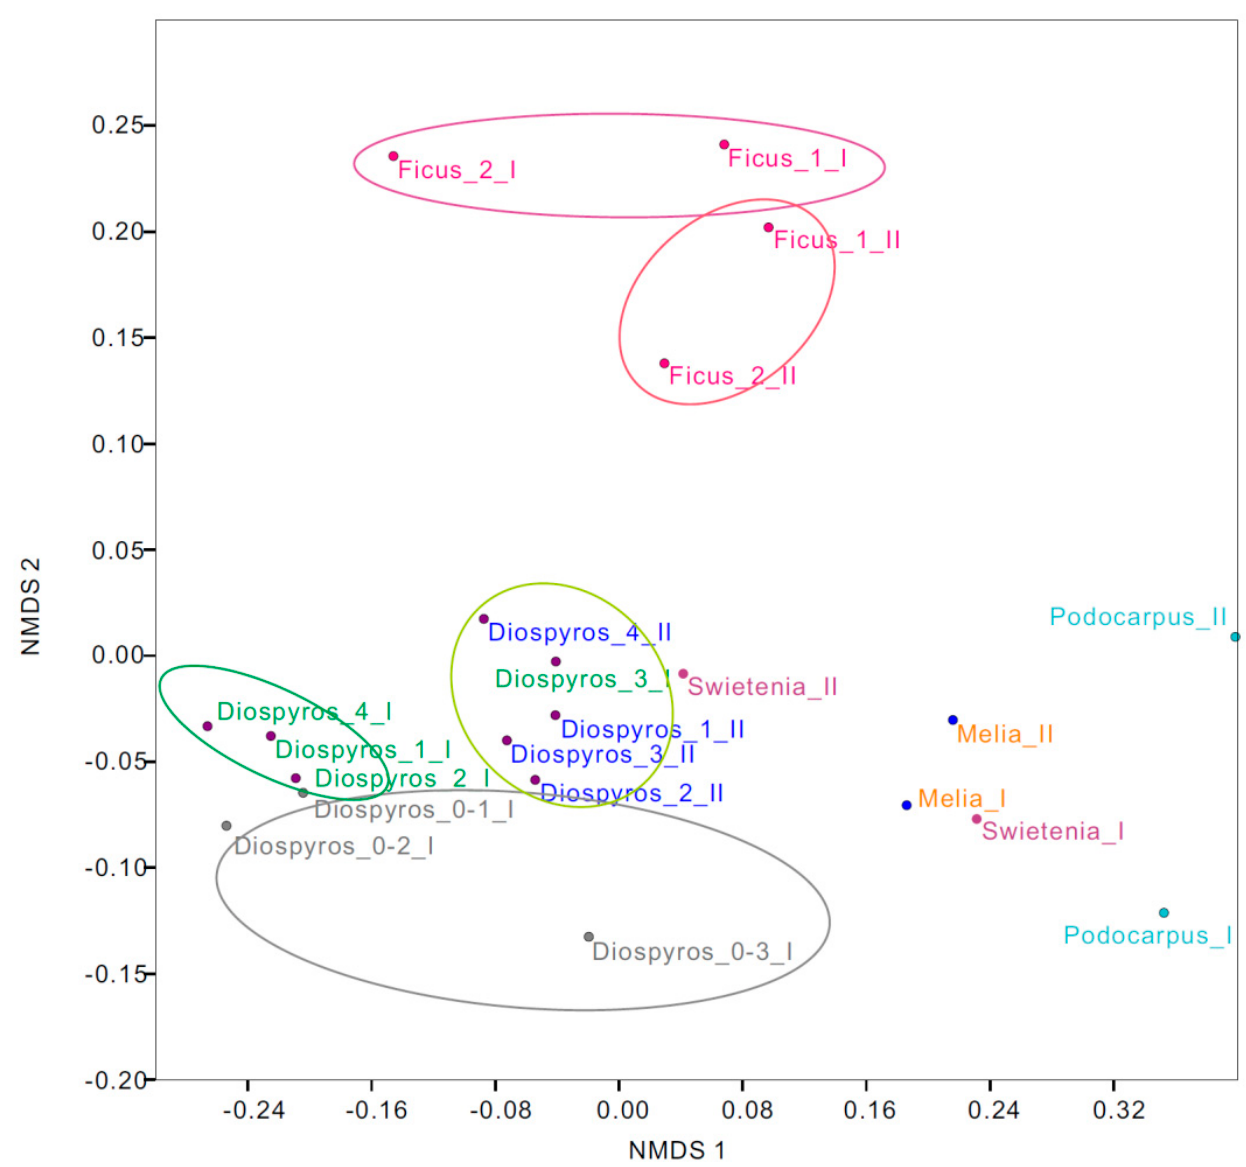
Figure 2. Nonmetric multidimensional scaling (NMDS) ordination of the nine urban trees at two study sites across the treatments based on bacterial communities. Diospyros = D. blancoi , Swietenia = S. macrophylla , Melia = M. azedarach , Podocarpus = P. nakaii , and Ficus = F. microcarpa across treatments at both sites. 0–1~0–3 denote the original soil; I and II denote soil after addition of biochar and of biochar/compost in combination, respectively. Stress =